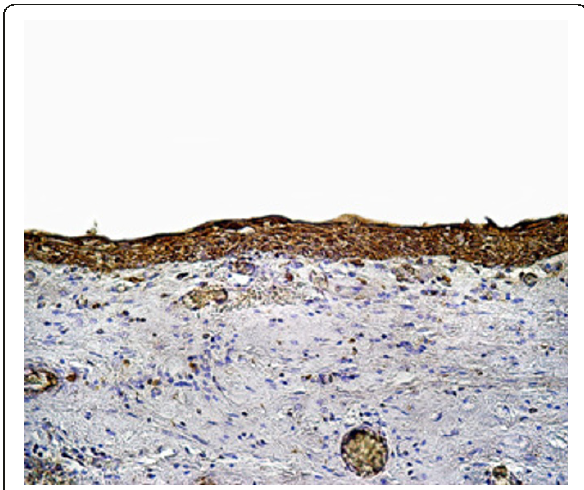
Figure 5 Photomicrograph of DC showing cytoplasmic immunoreactivity in epithelial cells, inflammatory cells and in endothelial cells of blood vessels (Anti-OPN. Original magnification x40) .